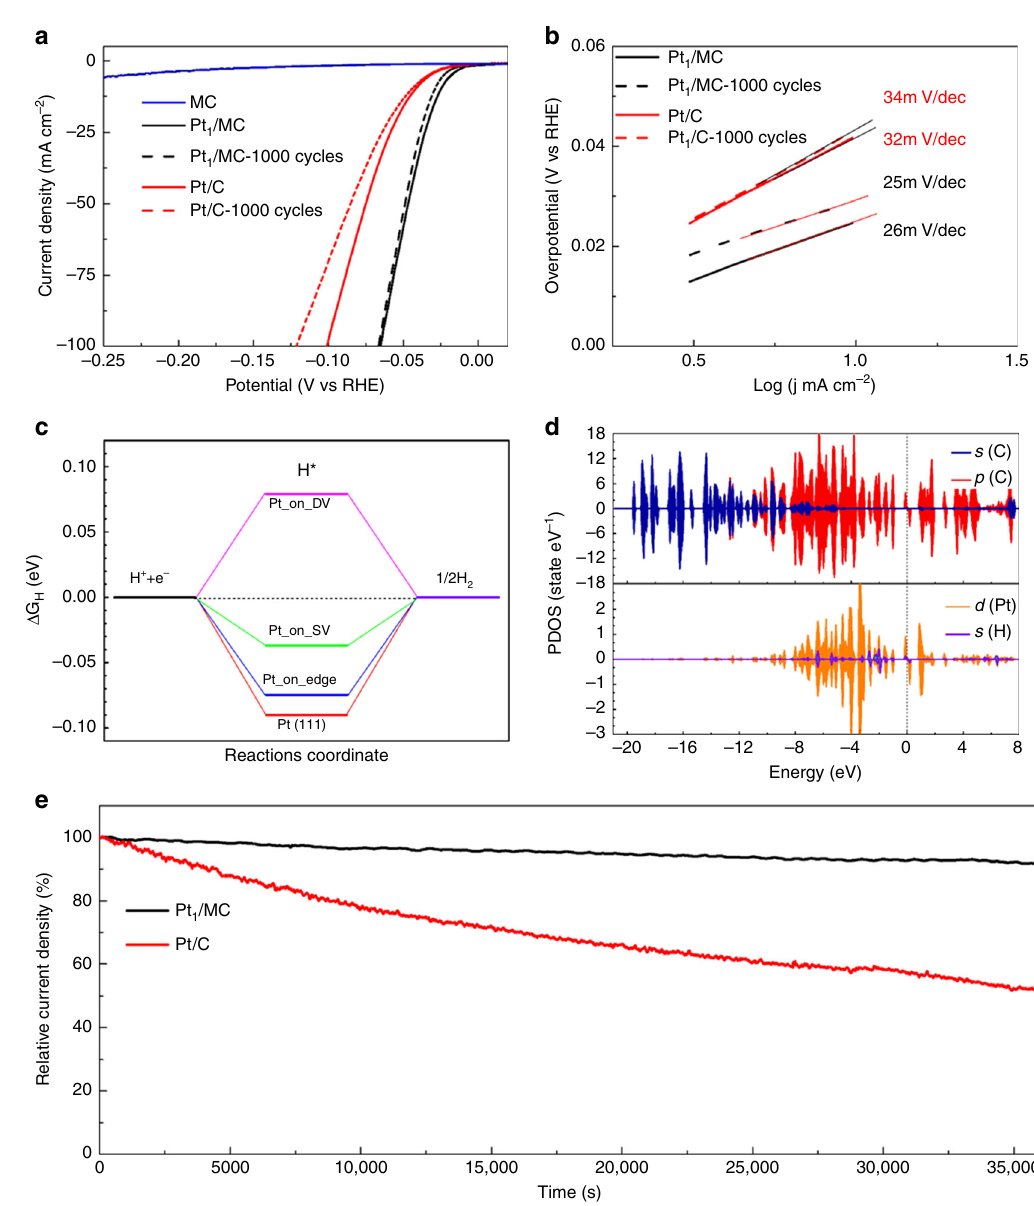
Fig. 4 HER activity of Pt 1 /MC and commercial Pt/C in 0.5 M H 2 SO 4 . a Polarization curves of Pt 1 /MC and Pt/C before and after 1000 CV cycles. b Tafel plots of Pt 1 /MC and Pt/C (collected before and after 1000 CV cycles). c Reaction mechanism for the HER, calculating Δ G H* for atomic H adsorption on different defects/edge on mesoporous carbon. d Partial density of states (PDOS) of the Pt adsorbed on a single vacancy system after H adsorption. The Fermi level is shifted to zero. e Long-time running of Pt 1 /MC and Pt/C electrocatalysts at the same overpotential of 30